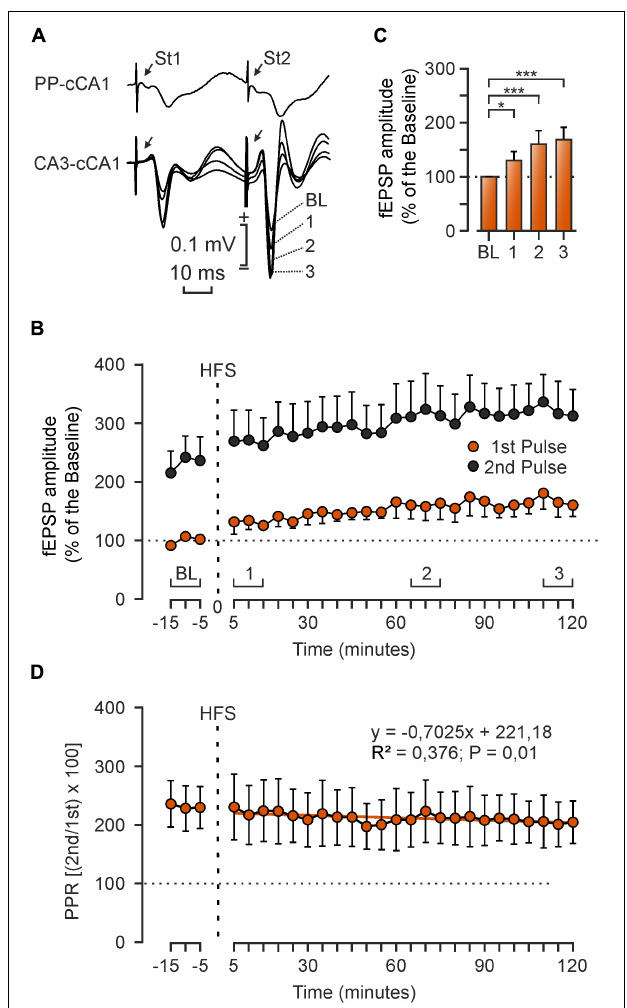
FIGURE 7 | Transsynaptic effects of LTP in alert head-fixed mouse. (A) Representative fEPSP collected from the PP-cCA1 and CA3-cCA1 synapses. (B) After presenting an HFS protocol to the ipsilateral PP, the LTP effects evoked in the CA3-cCA1 synapse persisted for at least 2 h. For the baseline, animals were stimulated every 20 s for 15 min in the CA3 area. The same stimuli were applied in the post-HFS recordings, which lasted 120 min. (C) Mean ± SEM. 1st pulse fEPSP values 1–15 min of baseline (BL), and 1–15 min (1), 65–75 min (2) and 110–120 min (3) after the HFS. Data were collected from 5 animals. * P < 0.05, *** P < 0.001 (one-way ANOVA). (D) The relationship between 2nd and 1st pulses—the paired-pulse ratio (PPR) calculated with the formula (2nd/1st × 100)—presents a linear regression line with a negative slope. Equations corresponding to the linear regression analyses of PPRs are indicated in the